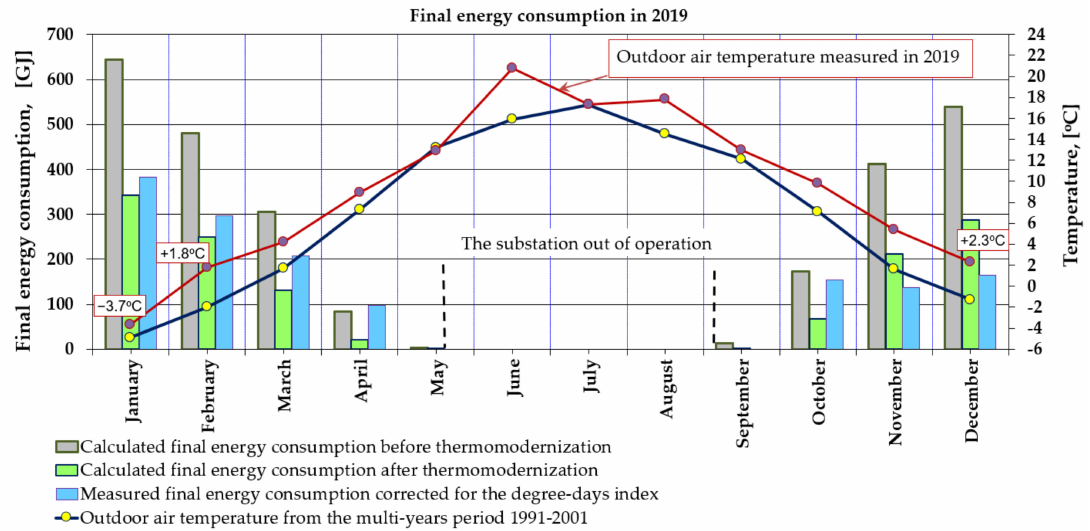
Figure 13. Final heat energy consumed for heating and ventilation needs of building A in 2019 and final energy corrected by the energy index of degree days ∂ together with the monthly outdoor air temperatures recorded in 2019 and the average outdoor air temperature for the multi-year period for the Bialystok weather